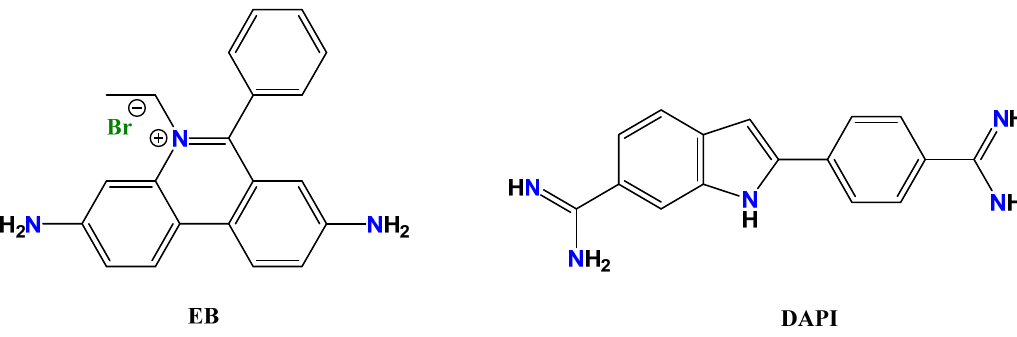
Chart 2. Fluorescent dyes used for displacement assays, ethidium bromide (EB) and